Question: How would you classify this visualization?
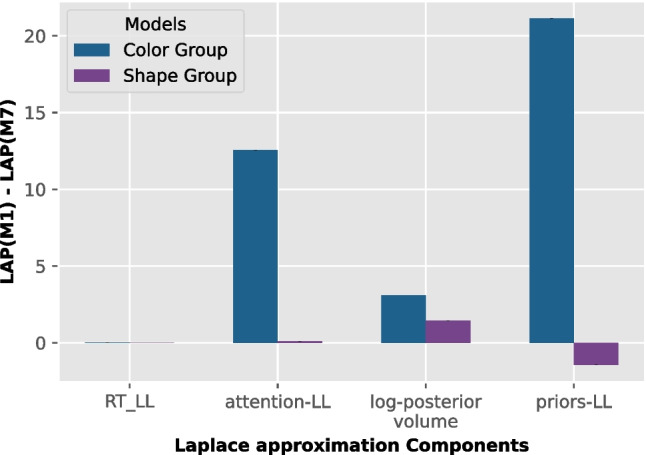
Answer: bar